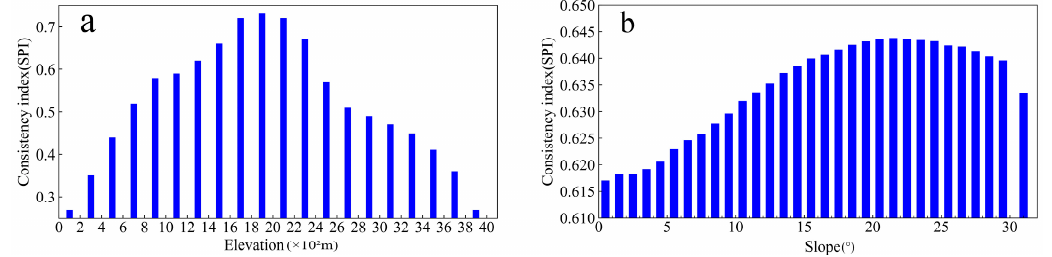
Figure 8. Variation of the spatial consistency index along different ( a ) elevation gradients, and ( b ) slope gradients.